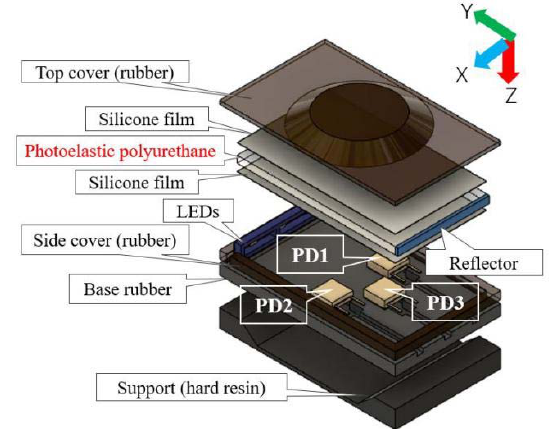
Figure 2. Material composition of the tactile sensor.